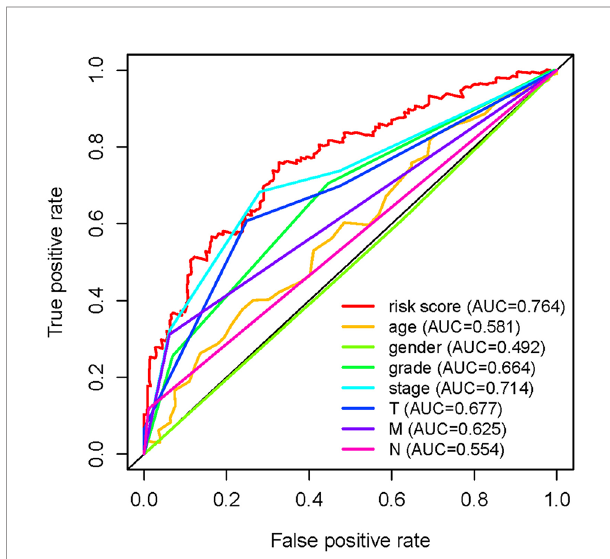
FIGURE 6 | Multi-receiver operating characteristic (ROC) curves. The prognostic value of the independent prognosis factors was indicated by ROC